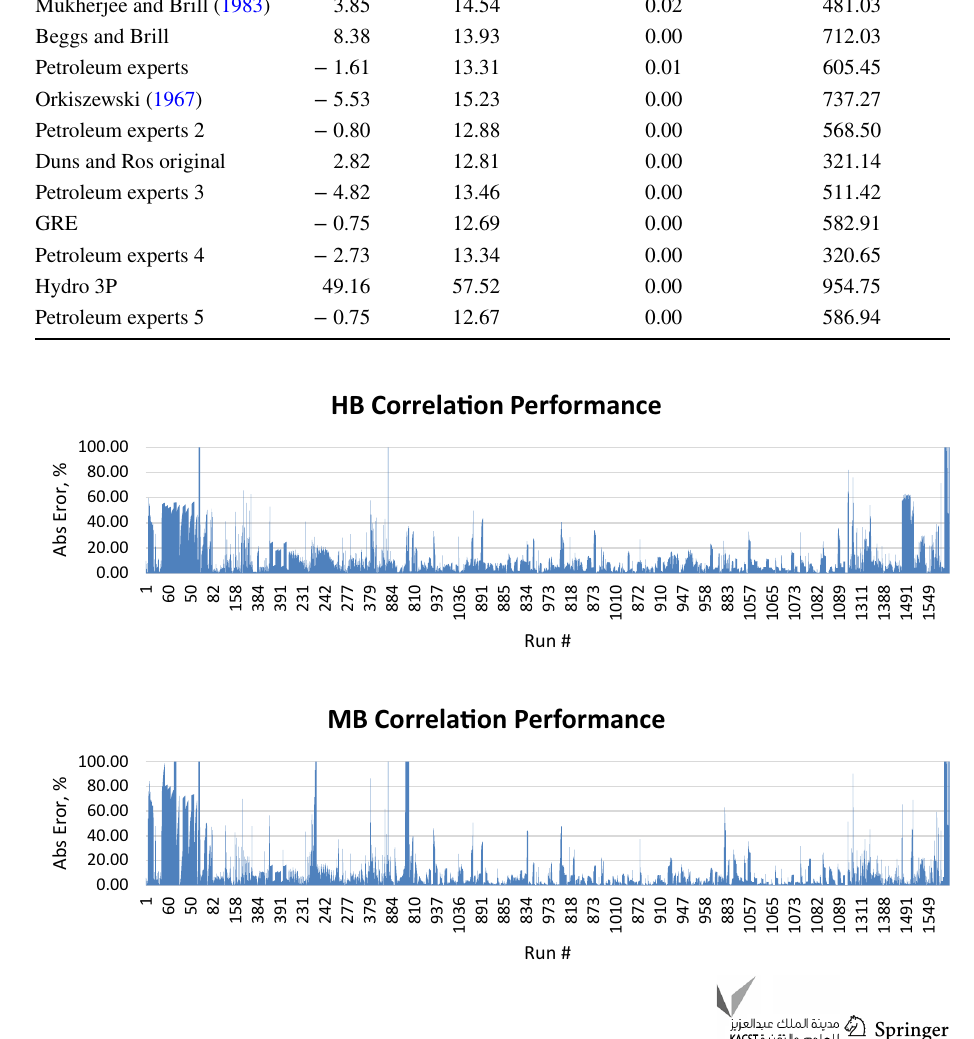
Correlation Prosper Software Help Manual, Petroleum Experts (2013)